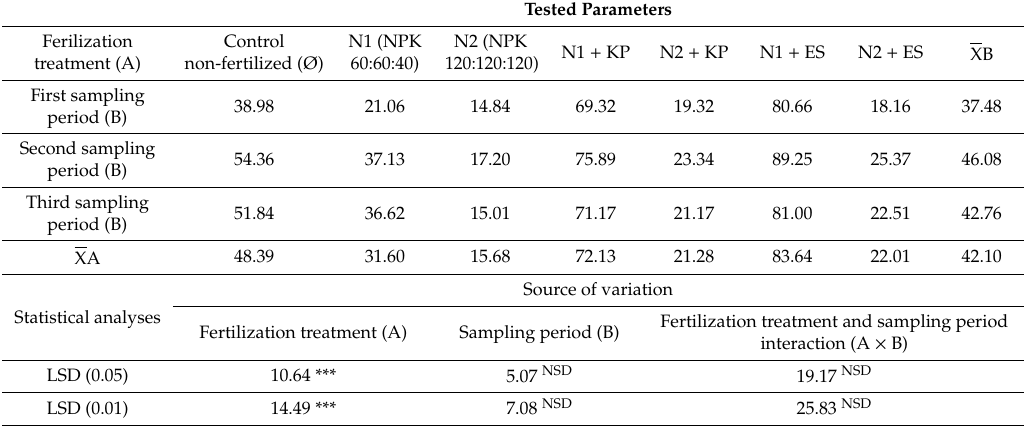
Table 5. Effect of the fertilization treatment (A), sampling period (B), and fertilization treatment and